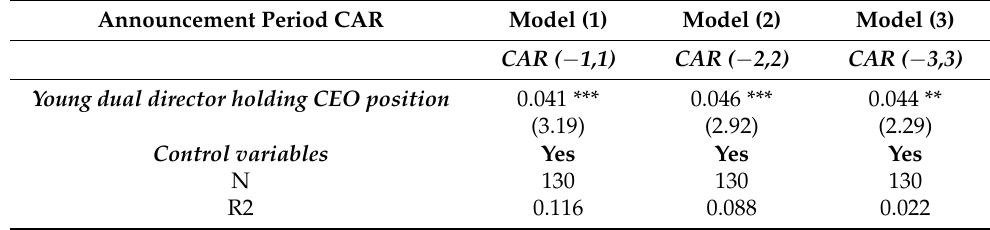
Table 9. Different cutoffs of young dual directors holding the CEO position. This table presents the results of OLS regressions of CAR surrounding the announcement day of the equity carve-out. Young dual director holding CEO position takes a value of 1 for firms with at least 1 young dual director holding the CEO position in the subsidiary firm and 0 otherwise. We use 65 years as the cutoff value . See Appendix A Table A1 for the variable definition. The t-statistics are in parentheses. **, and *** indicate significance at the 5%, and 1% levels,